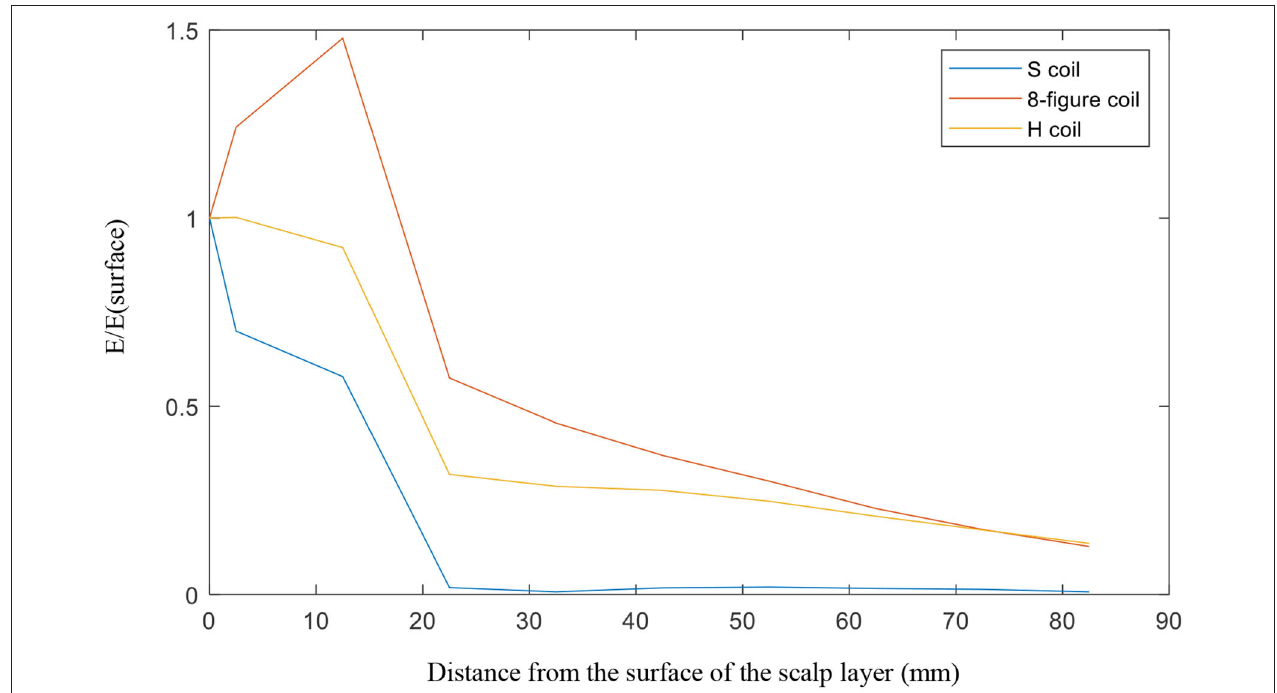
FIGURE 5 | Penetration depth.